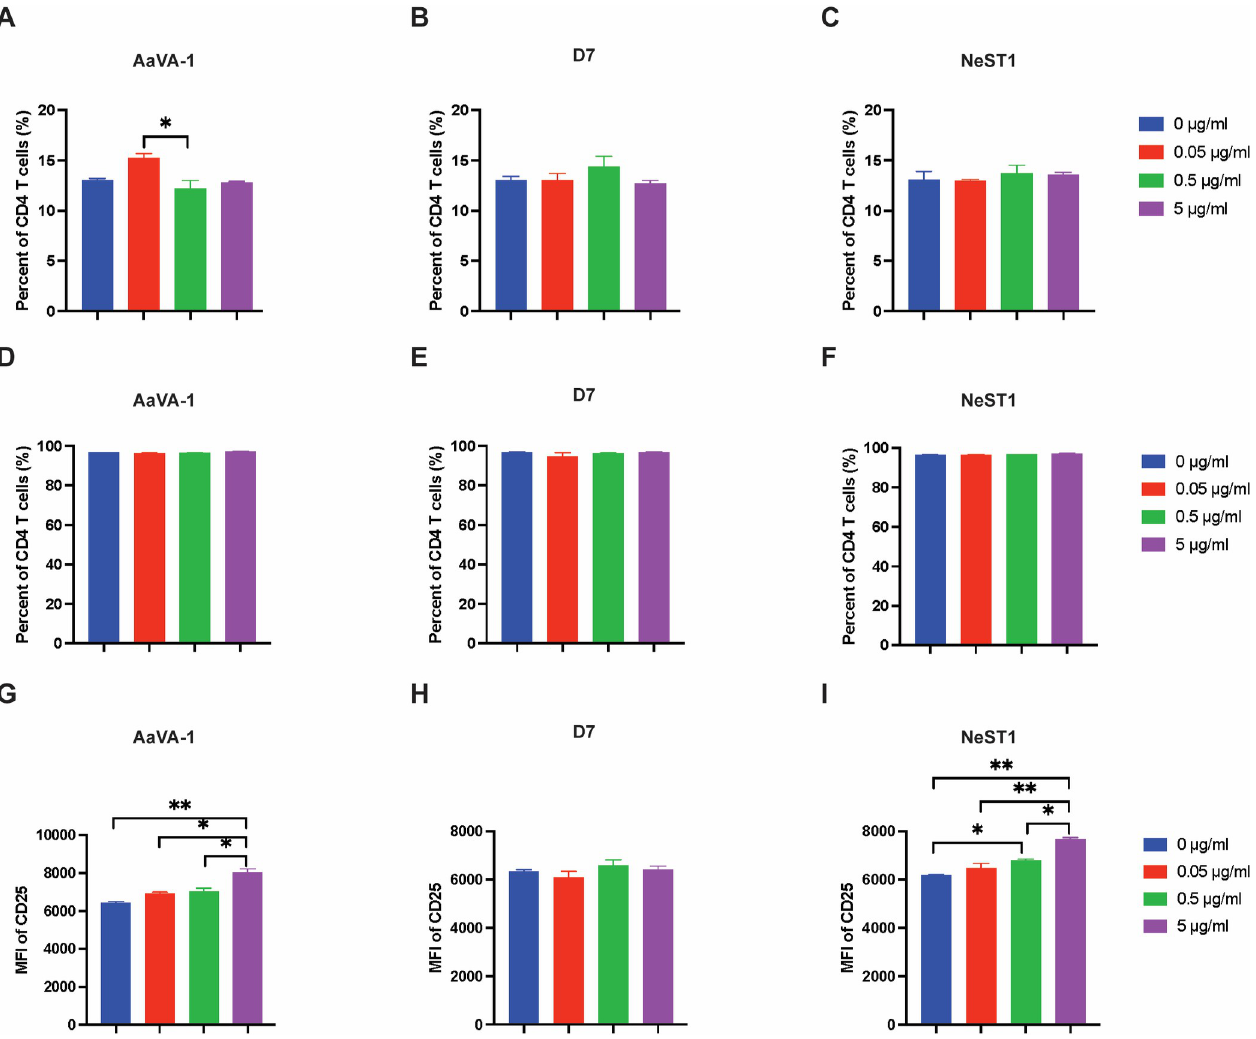
Fig 4. AaVA-1 and Nest1 enhance the activation of T cells. Human peripheral blood mononuclear cells (PBMC) with mosquito proteins at different concentration, 24 hours later activation marker CD69 and CD25 were measured. ( A-C ). Frequency of CD69 expression on CD4 + T cells was compared after different concentration of AaVA-1 ( A ), D7 ( AAEL006417 ) ( B ), or Nest1 ( C ) treated PBMC cells. ( D-F ). Frequency of CD25 expression on CD4 + T cells was compared after different concentration of AVAa-1 ( D ), D7 ( AAEL006417 ) ( E ), or Nest1 ( F ) treated PBMC cells. ( G-I ). Mean fluorescence of intensity of CD25 expression on CD4 + T cells was compared after different concentration of AaVA-1 ( G ), D7 ( AAEL006417 ) ( H ), or NeST1 ( I ) treated PBMC cells.